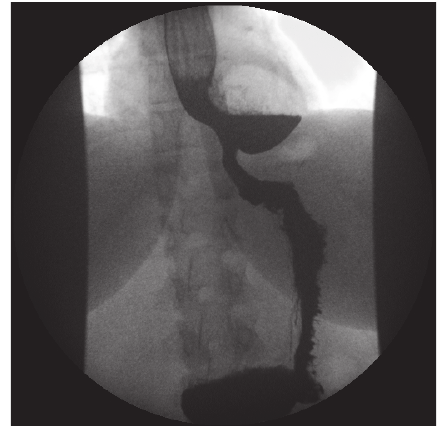
Figure 2: Oesophageal diverticulum with air-fluid level. Barium swallow.